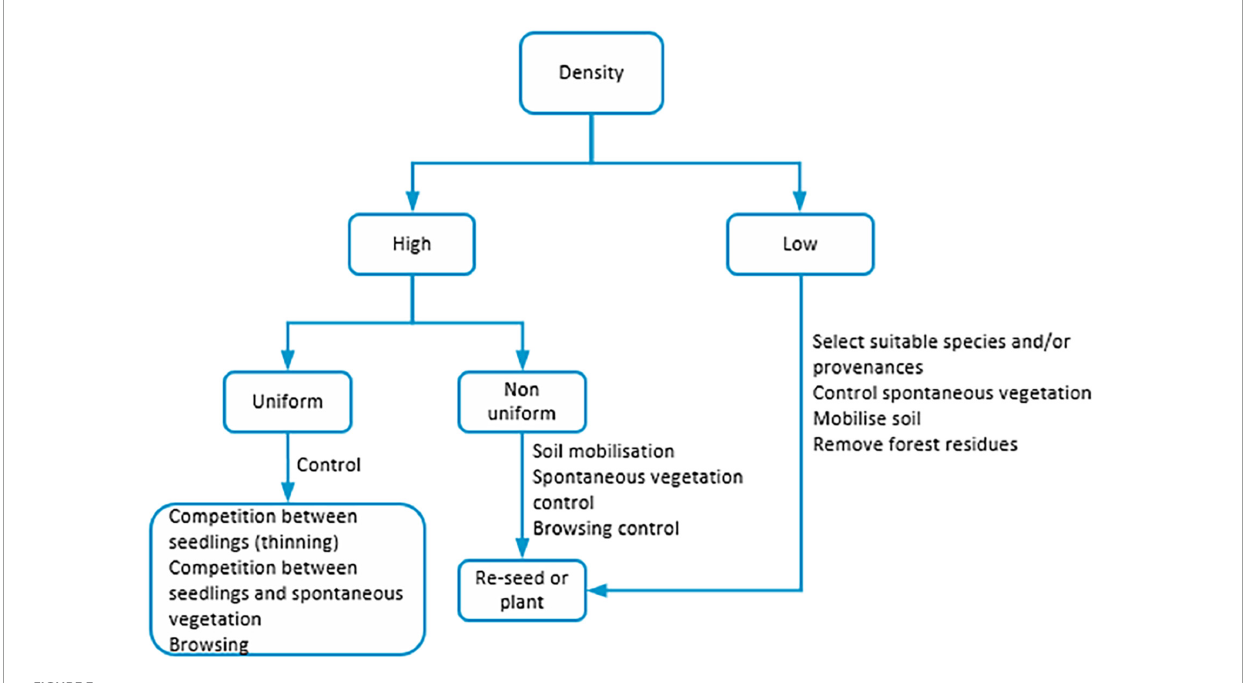
FIGURE3 Factors influencing direct